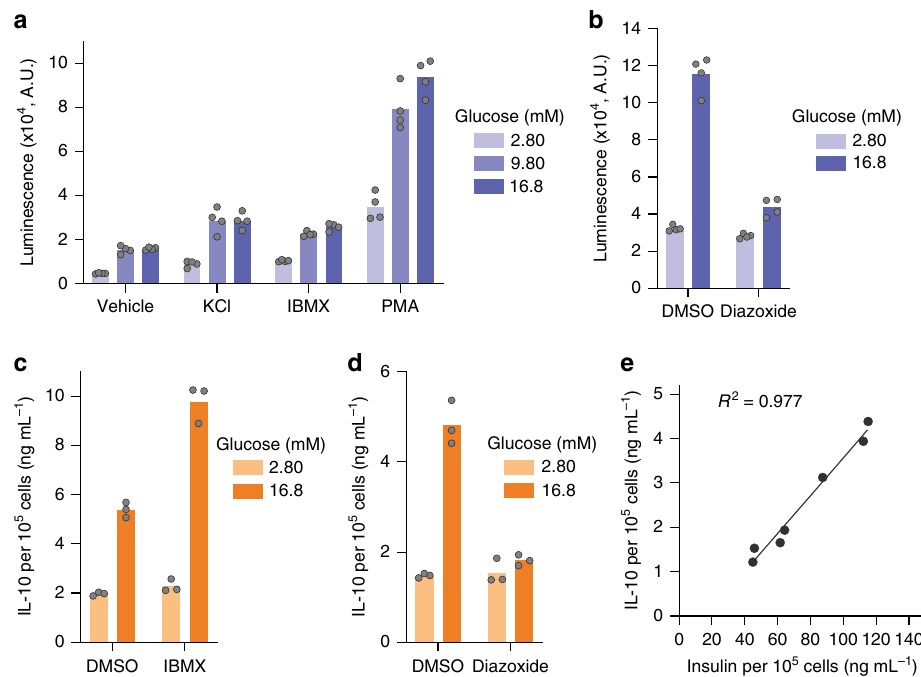
Fig. 6 Knockin products are secreted through the insulin secretion pathway. a , b Effect of a known insulin secretagogues and b diazoxide on the HiBiT peptide secretion ( n = 4 technical replicates). IBMX 3-isobutyl-1-methylxanthine. PMA phorbol 12-myristate 13-acetate. c , d Effect of c IBMX and d diazoxide on the IL-10 secretion ( n = 3 technical replicates). e Correlation between insulin secretion and IL-10 secretion under varying glucose concentrations (from 1.40mM to 16.8 mM). Data show means of n = 2 technical replicates. Source data are provided as a Source Data fi